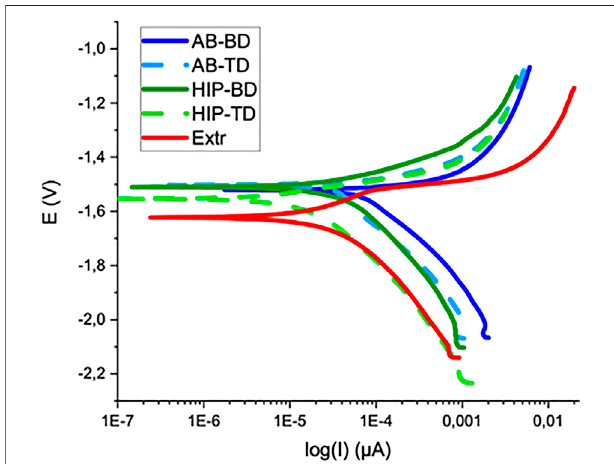
FIGURE 7 | Potentiodynamic testing curves for AB, HIP and Extr material.